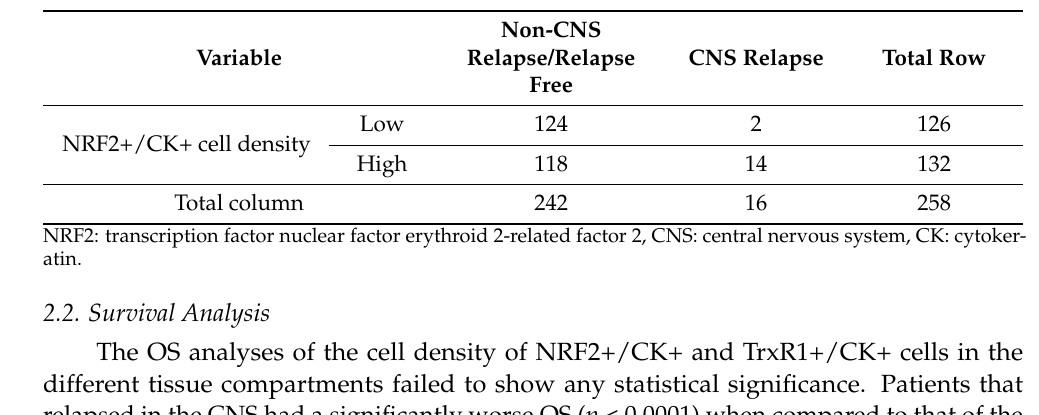
Table 2. Cross-tabs: correlation between NRF2+/CK+ cell density and risk of CNS